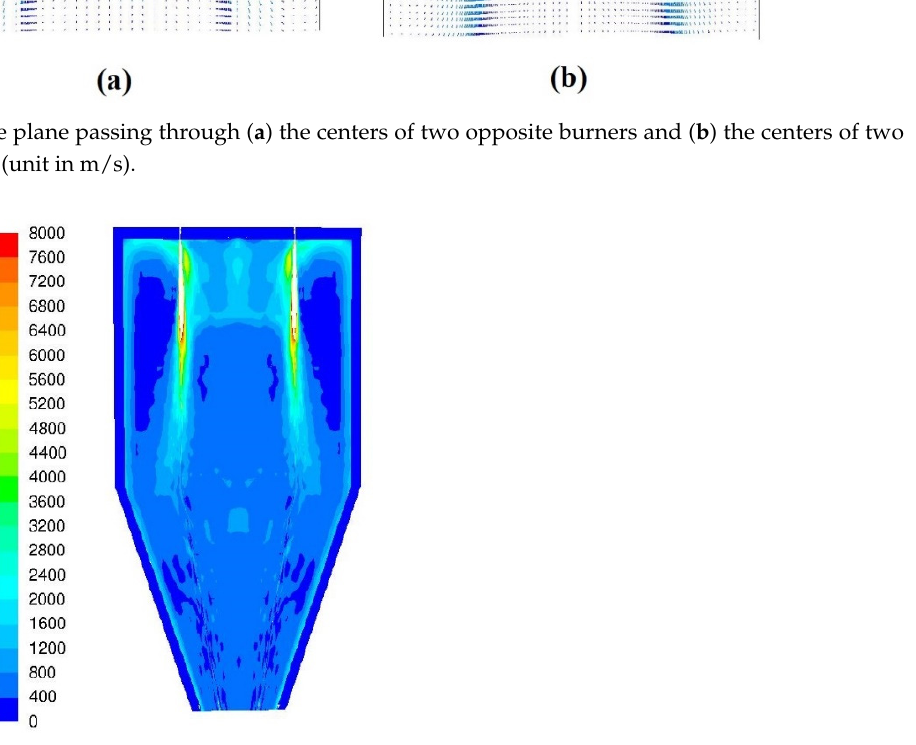
Figure 19. Particle number density (particles/cm 3 ) in the plane passing through the centers of two opposite powder feeding ports.